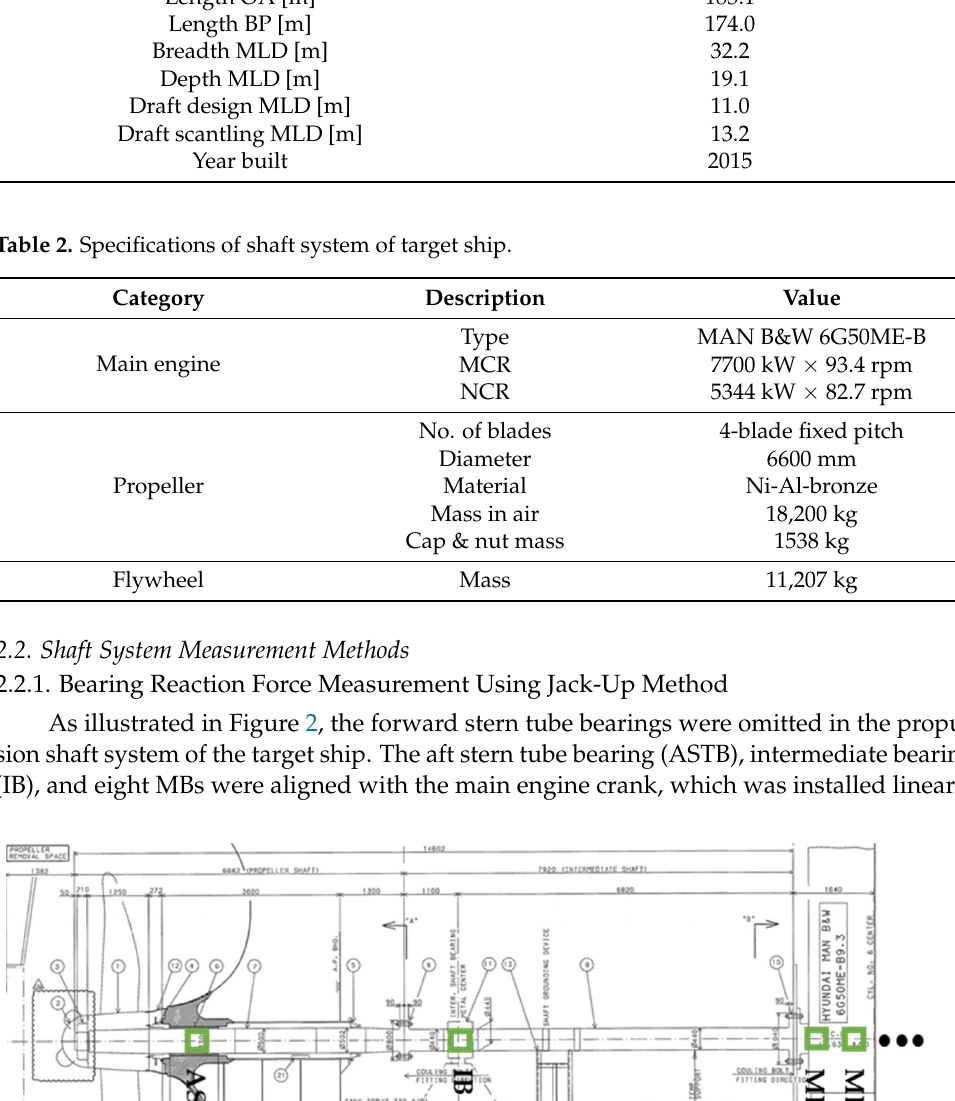
Table 1. Specifications of target ship.